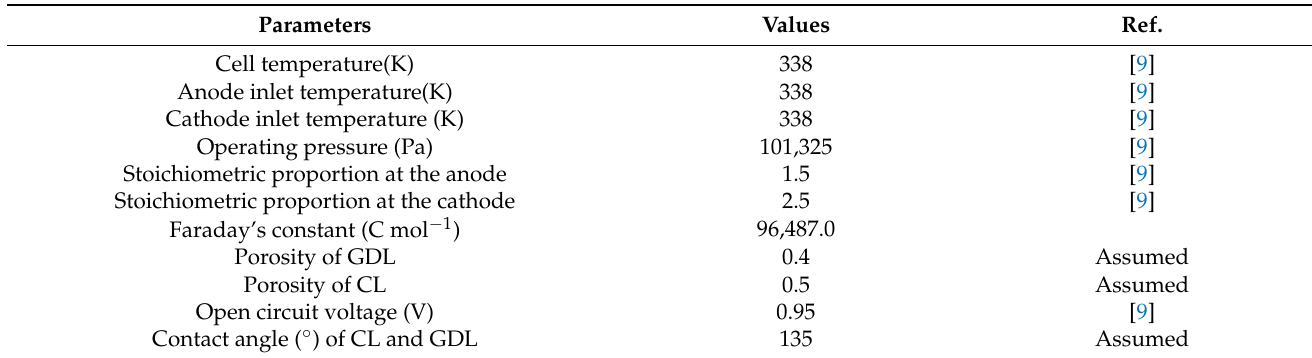
Figure 2. Computational grids in the simulation. Table 2. The operating conditions.